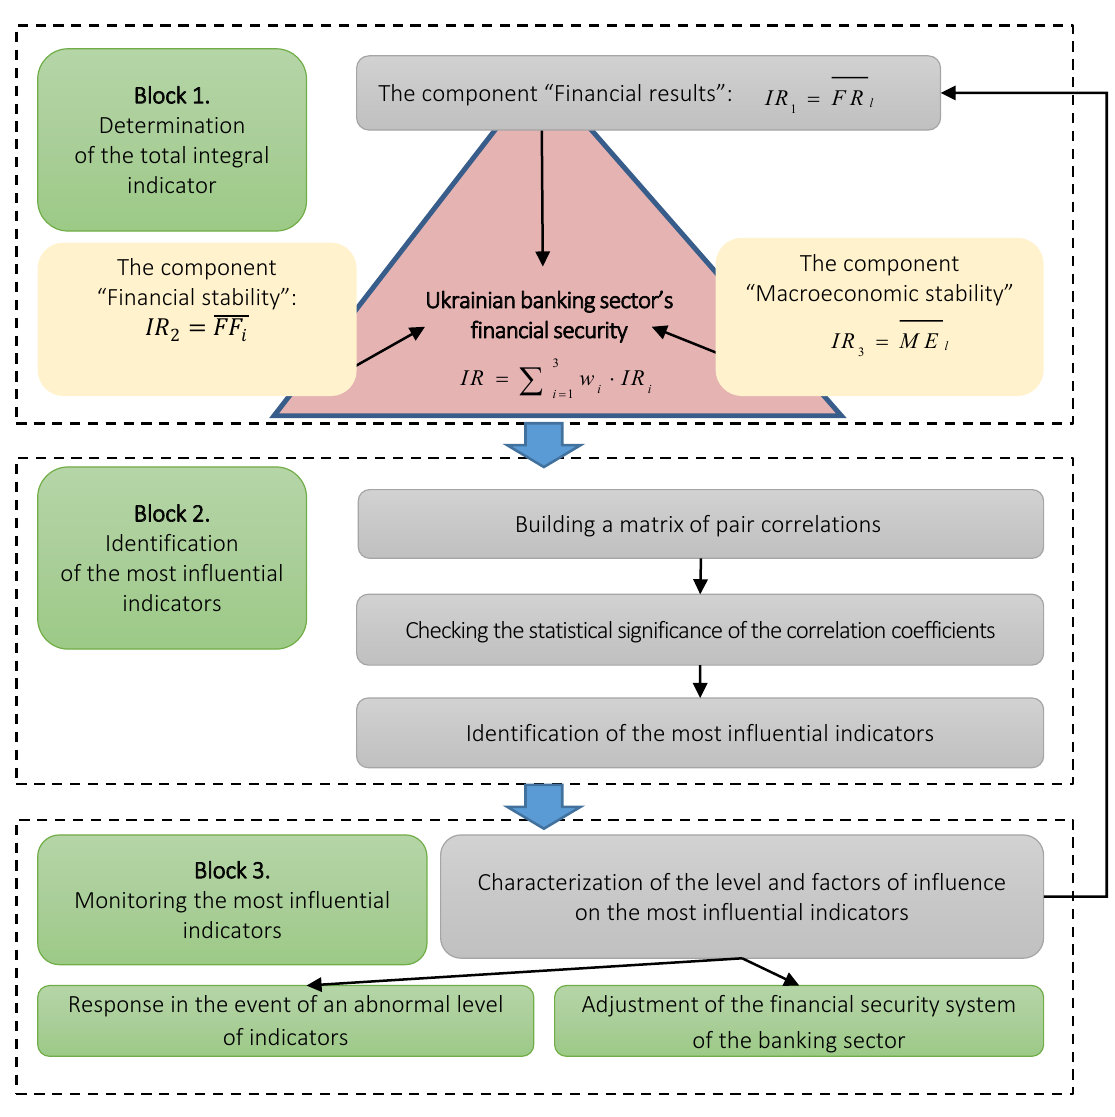
Figure A1. Algorithm for monitoring the Ukrainian banking sector financial